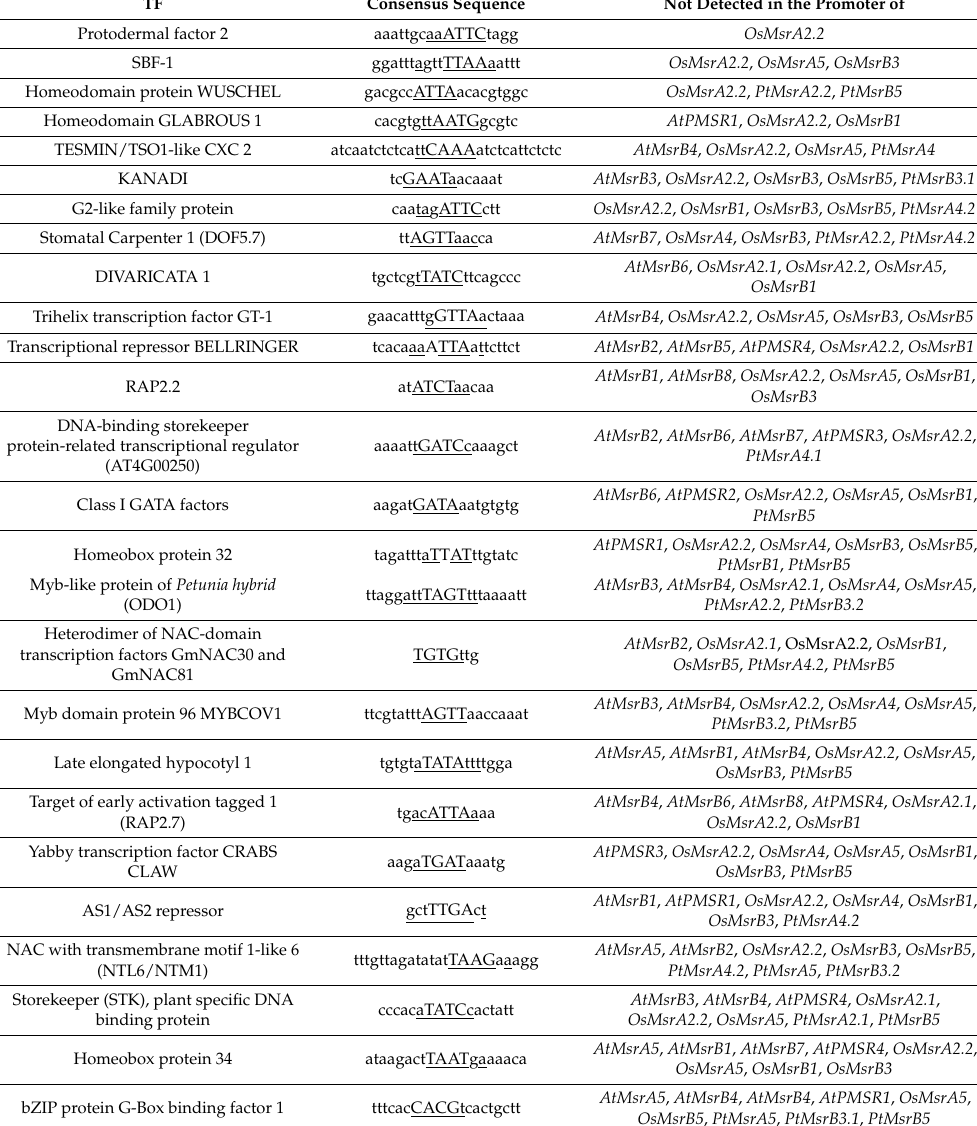
Table 2. List of TFs predicted to interact with the promoter region of at least 75% of 30 homological genes of methionine sulfoxide reductase type A ( MsrA ) and B ( MsrB ) originating from the Arabidopsis thaliana (At), Populus trichocarpa (Pt), and Oryza sativa (Os) genomes. The core consensus sequence of each TF is